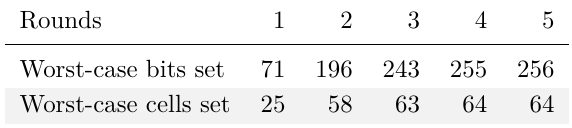
Table 3: Avalanche test starting with single bit